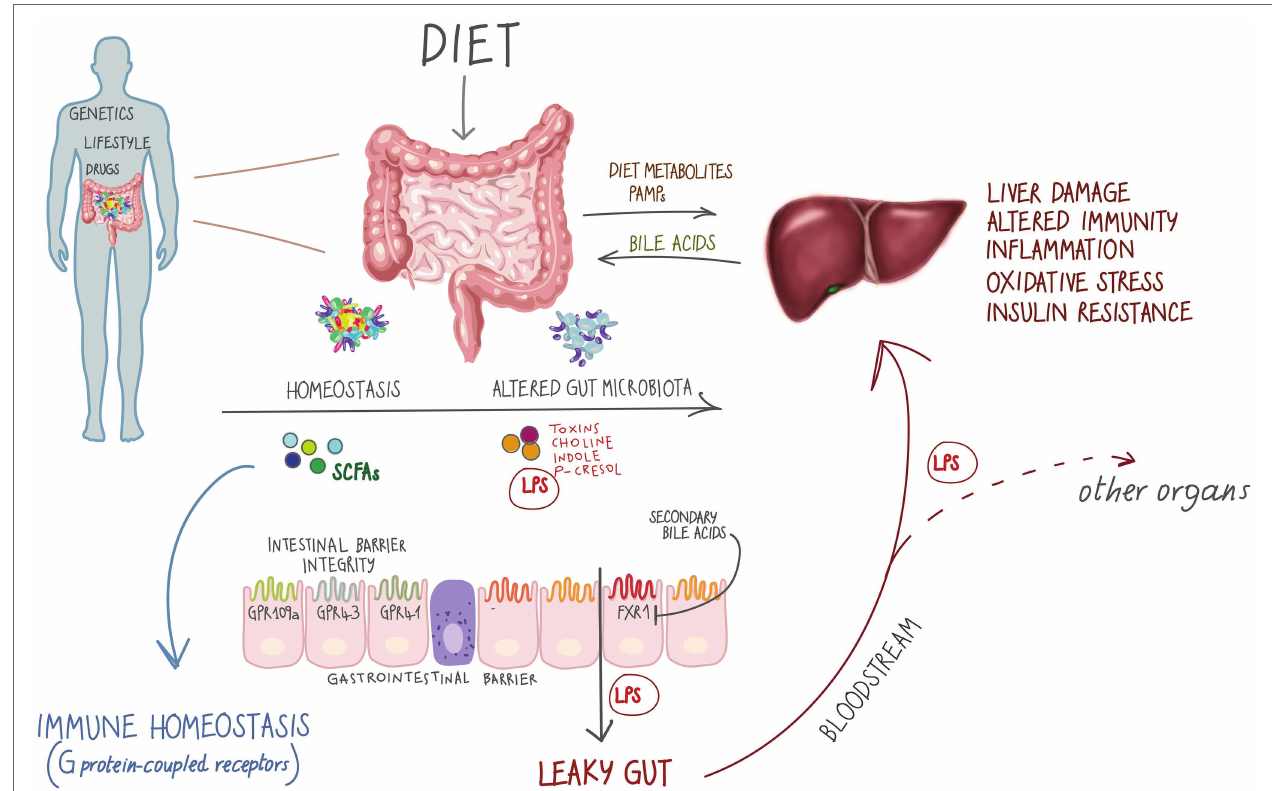
FIGURE 1 | The gut-liver axis and metabolic diseases. Metabolic diseases affect the gut-liver axis through exposome factors such as diet, xenobiotics, sedentary lifestyle as well as genetic treats. On the other hand, in inborn errors of metabolism (IEMs), special diets represent an important modulator of microbiota, impacting the gut-liver axis by altering microbial metabolites production. short-chain fatty acids (SCFAs) interact with metabolite-sensing G protein-coupled receptors GPR4, GPR43 and GPR109A promoting gut homeostasis (Macia et al., 2015) that has a central role in many human body functional axes. Alterations in the microbial community might promote a leaky gut condition, by altering gut barrier permeability and allowing translocation of whole bacteria and metabolites, such as lipopolysaccharide (LPS), further affecting the gut-liver axis and participating in non-communicable disease